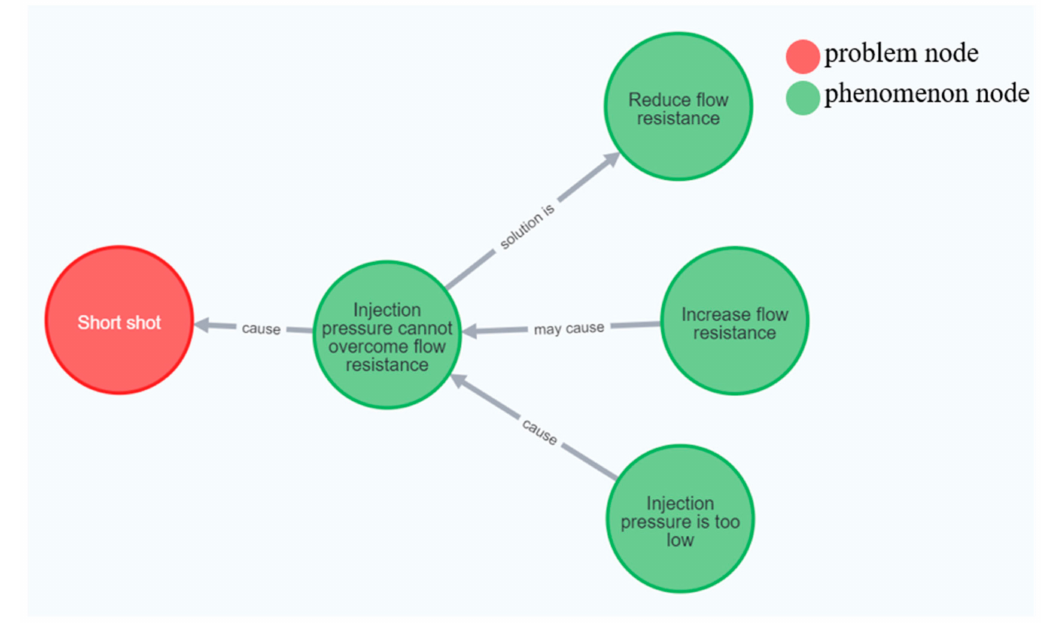
Figure 2. Phenomenon Nodes.